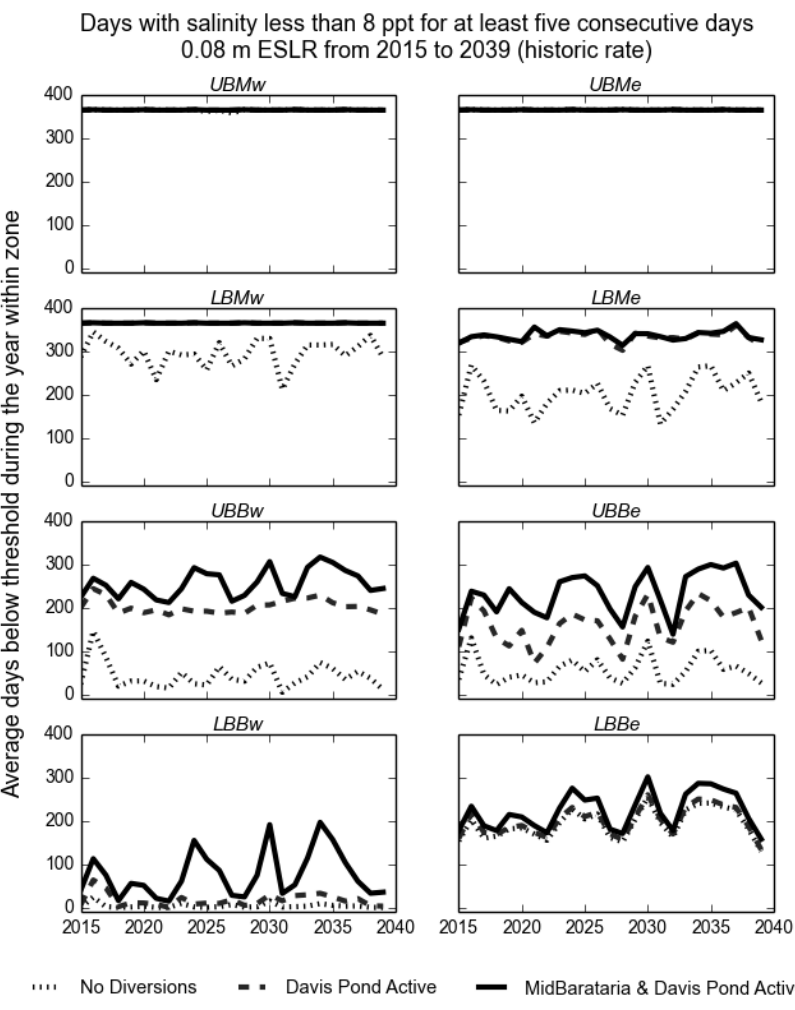
Figure 12. Mean number of days in a year for each zone where daily mean salinity was below 8 ng/kg for at least five consecutive days for three simulations under historic sea level rise rates: no diversions active (dotted), only Davis Pond active (dashed), and both Davis Pond and Mid-Barataria diversions active (solid).